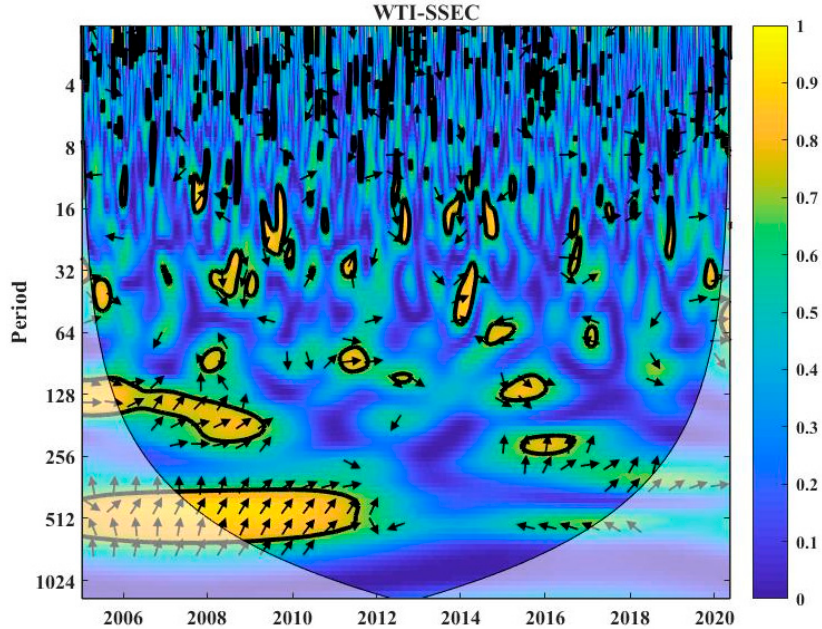
Figure A1. Wavelet coherent frequency spectra of WTI spot price and the Shanghai Composite Index.